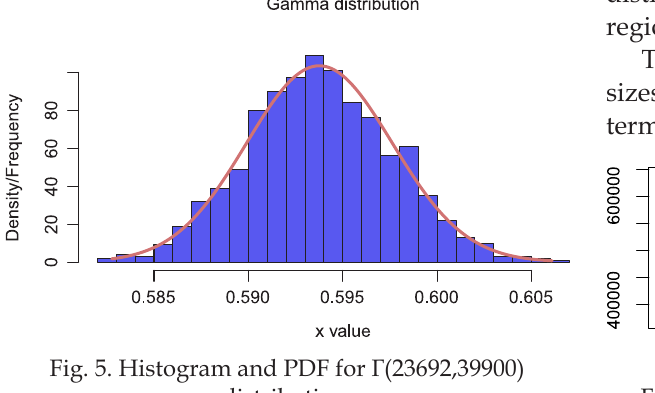
Fig. 7. Firms distribution in a hexagonal region. Source: own study.